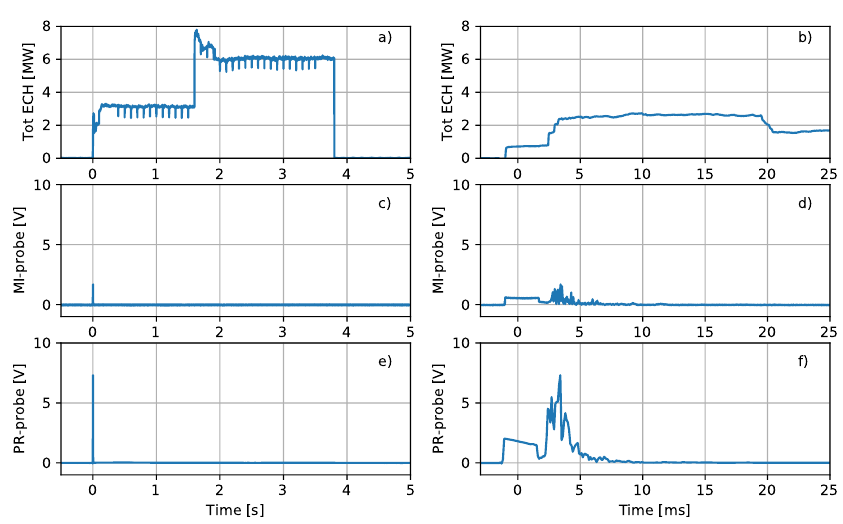
Figure 3: Data for # 171207009. Traces in the left hand column show the overall discharge, traces in the right hand column a zoom on plasma start-up. Top: ECRH total power, center: the Profile Reflectometer stray radiation probe and lower the Michelson Interferometer stray radiation probe.